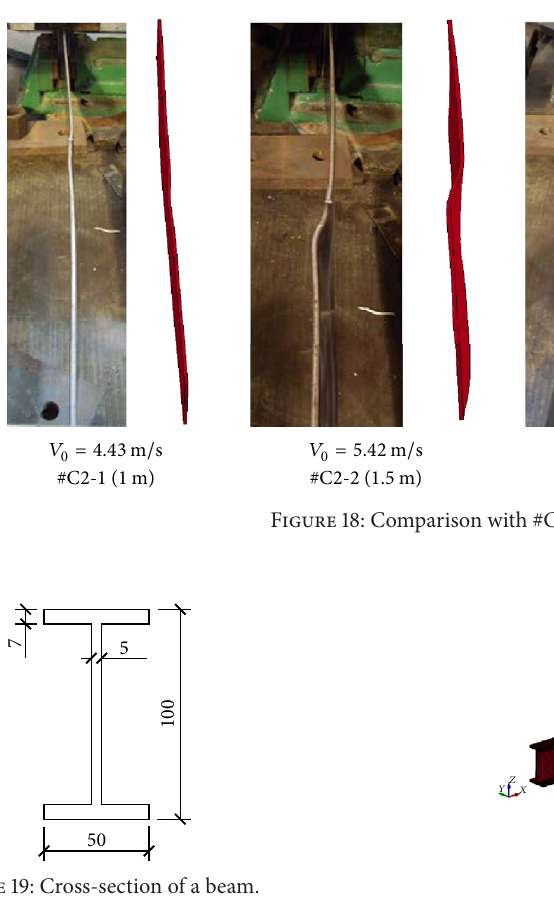
Figure 19: Cross-section of a beam.